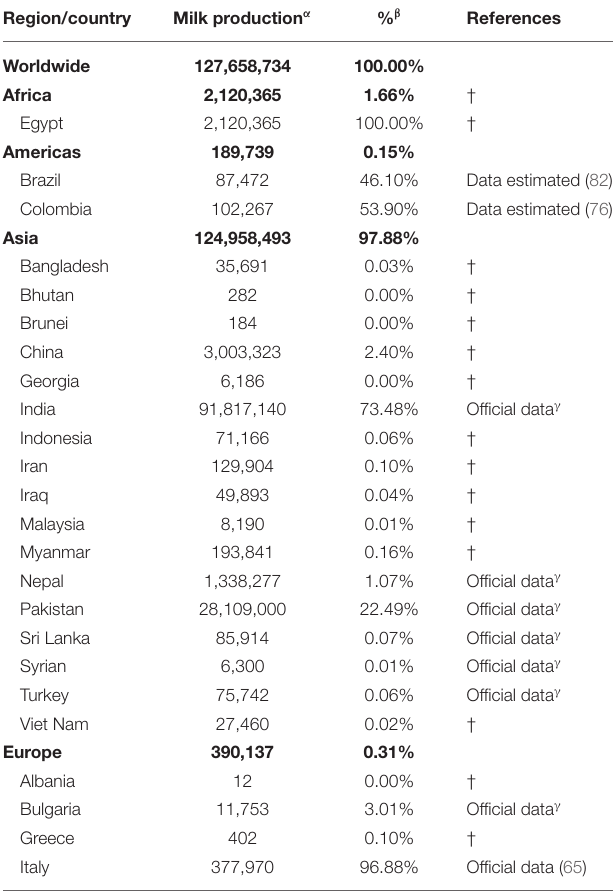
TABLE 4 | Current data on buffalo milk production